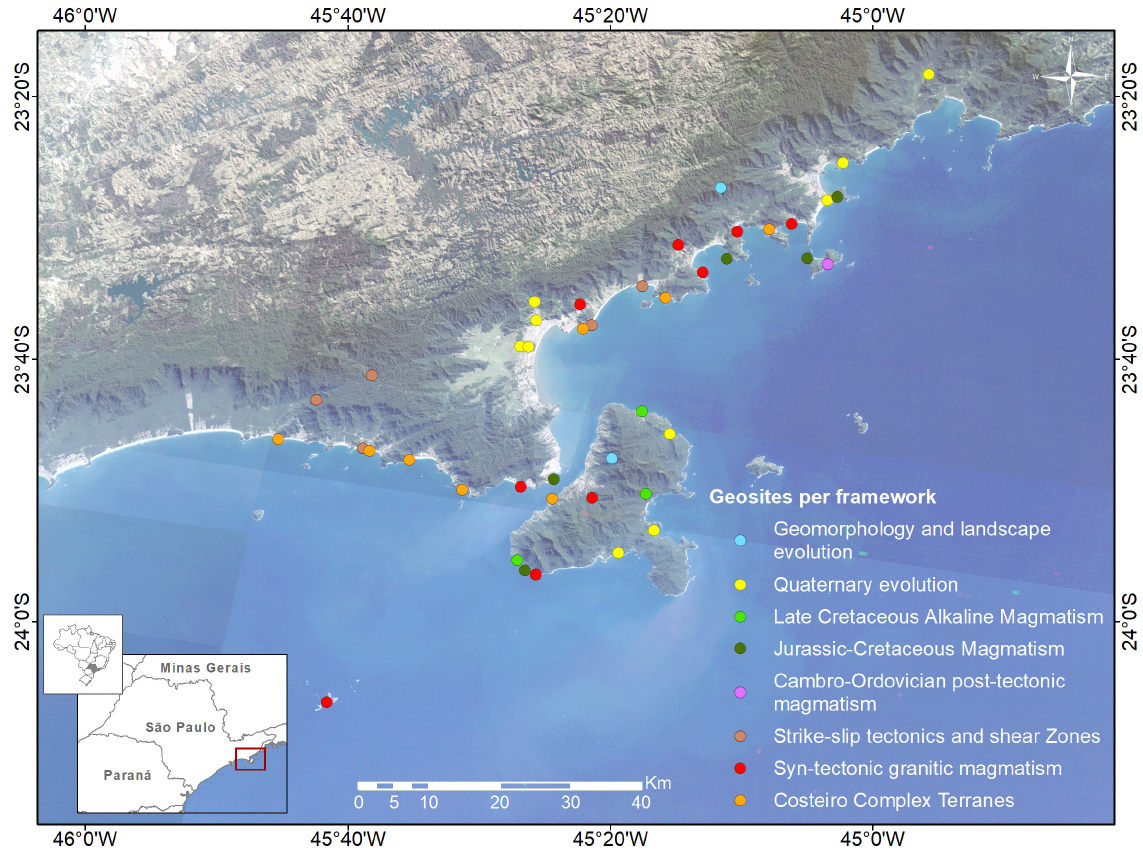
Figure 1. Map of the northern coast of São Paulo, with the location of the 43 geosites distributed in eight frameworks, coded by color. Source: Garcia et al .